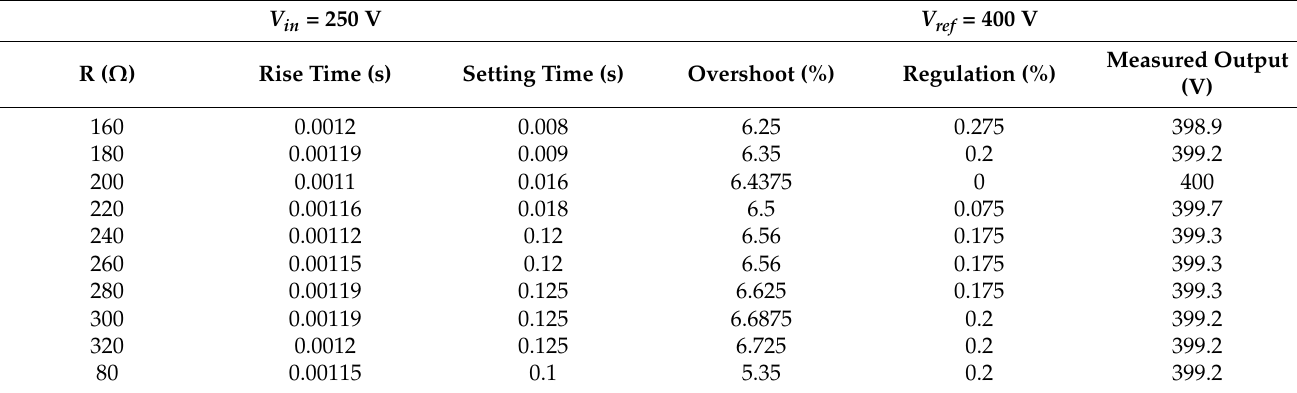
Table 4. Performance parameters of proposed HG-SIQBC for V in = 250